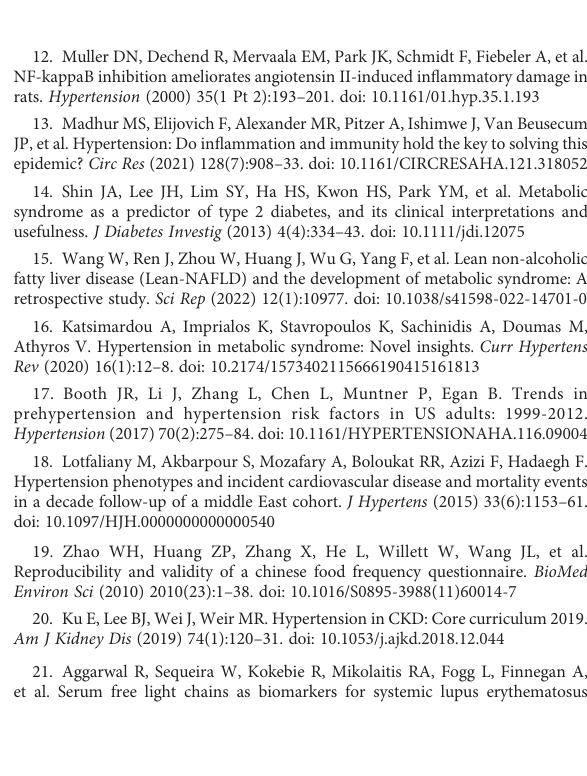
SUPPLEMENTARY FIGURE 1 Medication usagesonfecalmycobiome.Comparisonoffecalmycobiome between antihypertensive agent users and non-users. Permutational multivariate analysis of variance (PERMANOVA) was performed for statistical comparisons of samples in the two groups. P value was adjusted by the Benjamini and Hochberg false discovery rate (FDR). SUPPLEMENTARY FIGURE 2 Hypertension phenotypes on fecal mycobiome. Comparison of fecal mycobiome among hypertension phenotypes. Permutational multivariate analysis of variance (PERMANOVA) was performed for statistical comparisons of samples in the two groups. P value was adjusted by the Benjamini and Hochberg false discovery rate (FDR). A bbreviations: IDH: isolated diastolic hypertension; ISH, isolated systolic hypertension; SDH: systolic-diastolic